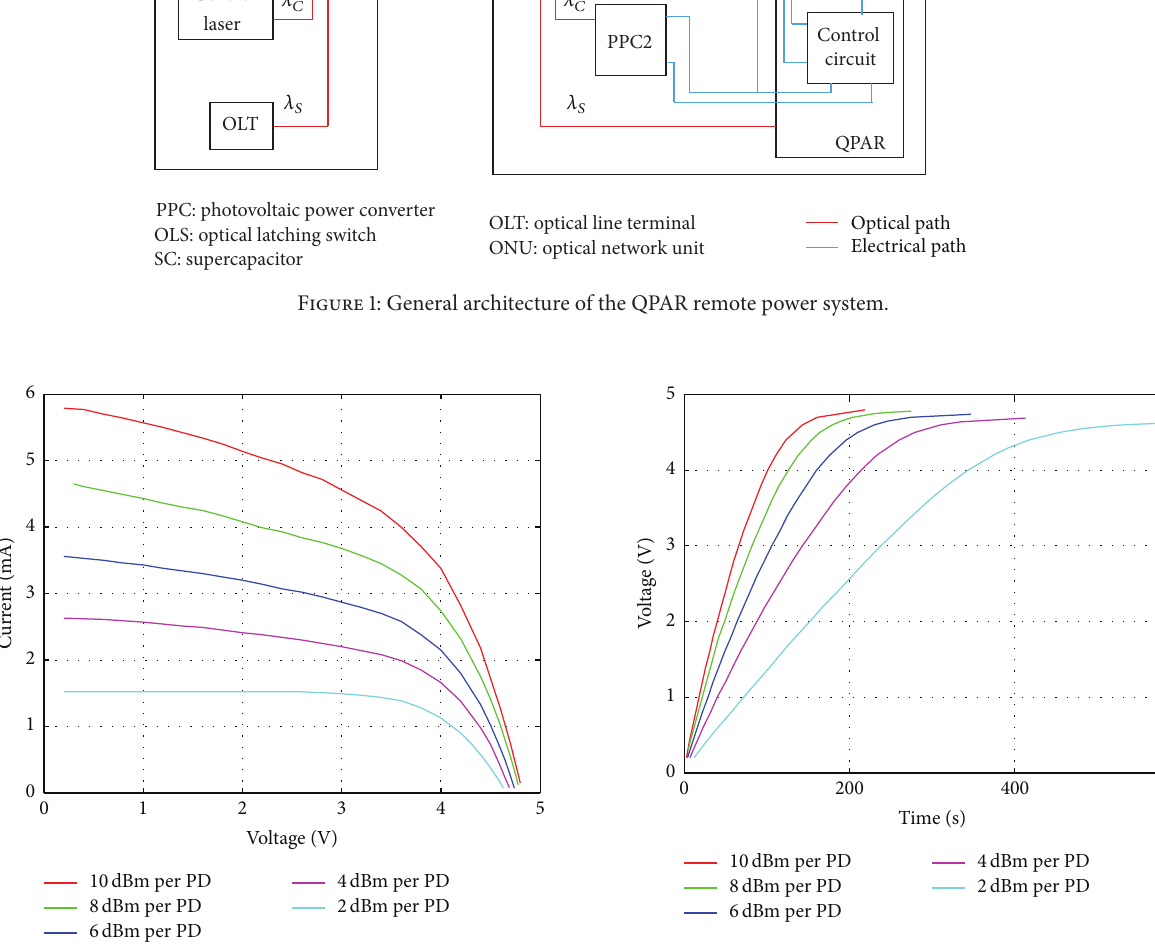
Figure 3: Experimental charging curves of a 0.1 F SC.